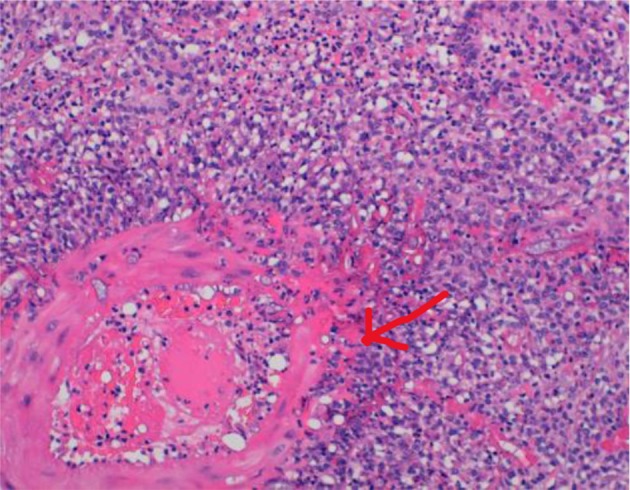
HE stain of bowel biopsy. Cores of fibrous tissue with extensive necrotizing granulomatous inflammation with many foreign body type multinucleated giant cells (see red arrow) and large numbers of eosinophils.